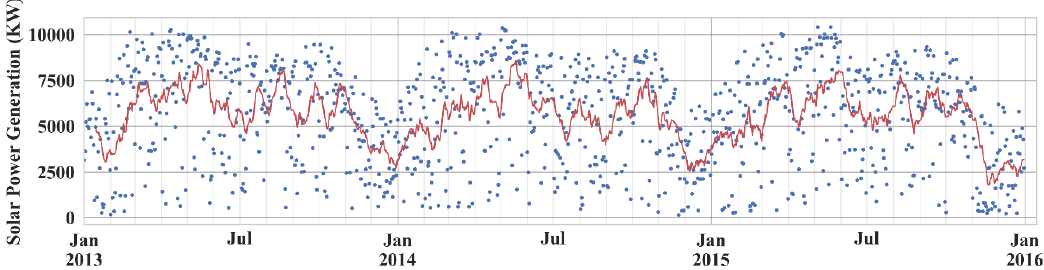
Figure 2. Solar power generation per day at Yeongam solar power plant from January 2013 to December 2015.